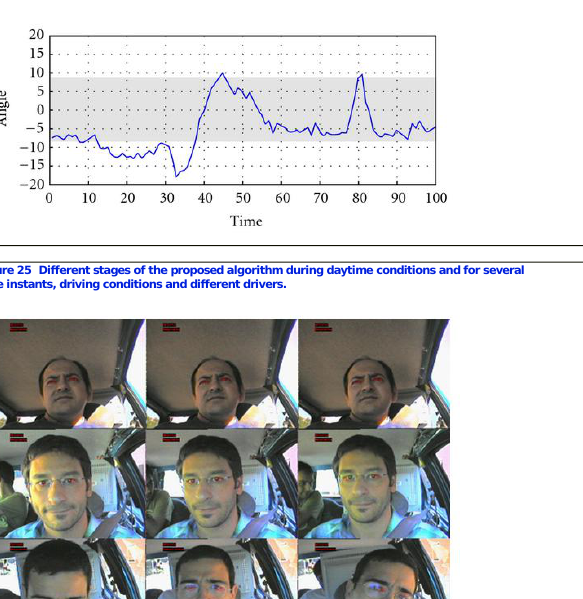
Figure 24 Head-orientation monitoring over time in a 100-frame sequence.